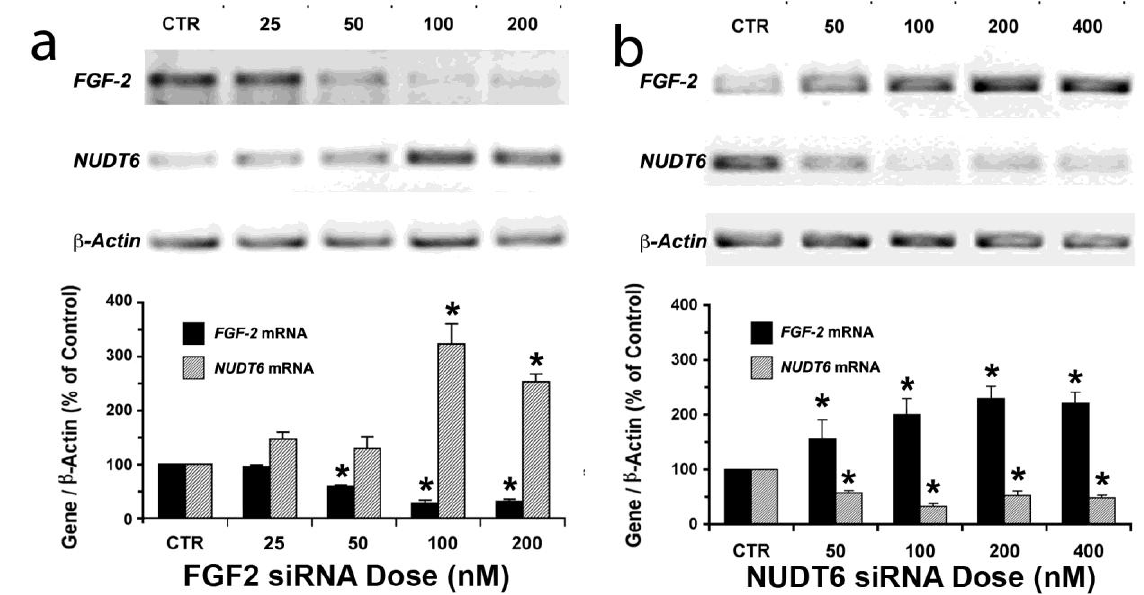
Figure 1. Dose-dependent reciprocal effects of siRNA knockdown on FGF2 and NUDT6. ( a ) FGF2 knockdown up-regulates the antisense (NUDT6) mRNA; and ( b ) NUDT6 knockdown up-regulates FGF2 mRNA. C6 glioma cells were transfected with the indicated doses of siRNA or 100 nM negative control (CTR) siRNA. Total RNA was isolated after 48 hours for RT-PCR. Expression intensity was normalized against (cid:533) -actin amplified from the same RT reaction. * significantly different from control, p < 0.05, n =